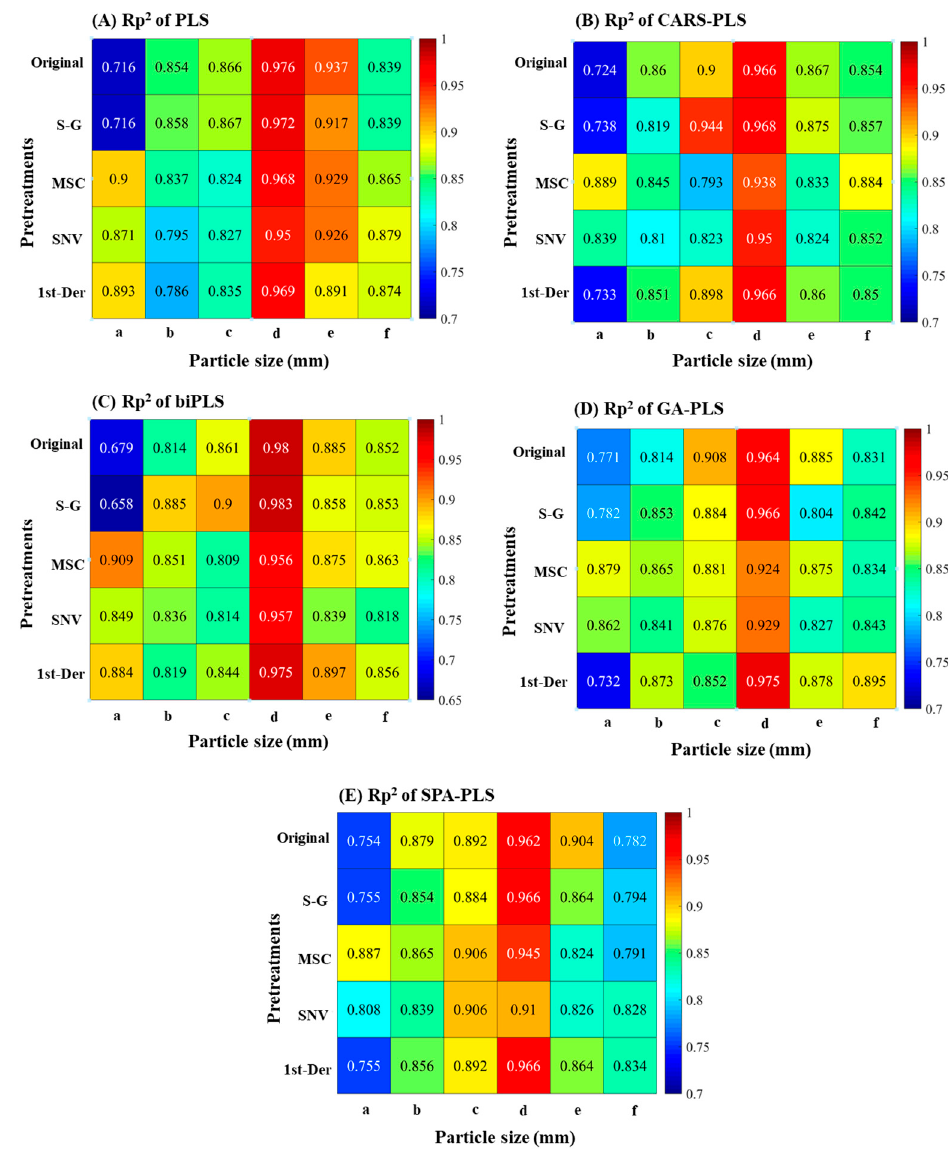
Figure 4. The prediction determination coefficients of four different preprocessing methods and five different models. Models: ( A ) partial least squares (PLS); ( B ) competitive adaptive reweighted sampling—partial least squares (CARS-PLS); ( C ) backward interval partial least squares (biPLS); ( D ) genetic algorithm—partial least squares (GA-PLS); ( E ) successive projections algorithm—partial least squares (SPA-PLS). Soil particle sizes: (a) 1–2 mm; (b) 0.45–1 mm; (c) 0.28–0.45 mm; (d) 0.18–0.28 mm; (e) 0–0.18 mm; (f) 0–2 mm.